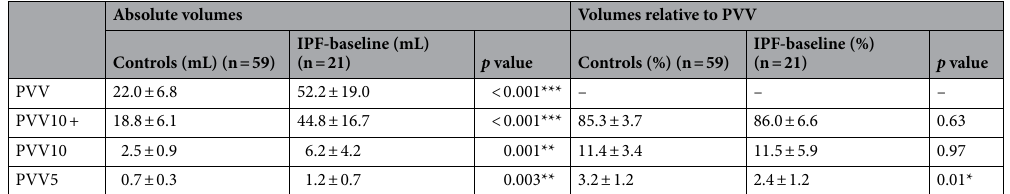
Table 2. PVV and its sub-volumes for IPF at baseline and controls, for graph-based estimates of PVV. Sub- volumes are given as percentages of PVV. Data are given as mean ± standard deviation. Independent t-test p values indicated by: *(significance at the 0.05 level), **(significance at the 0.01 level), ***(significance at the 0.001 level).